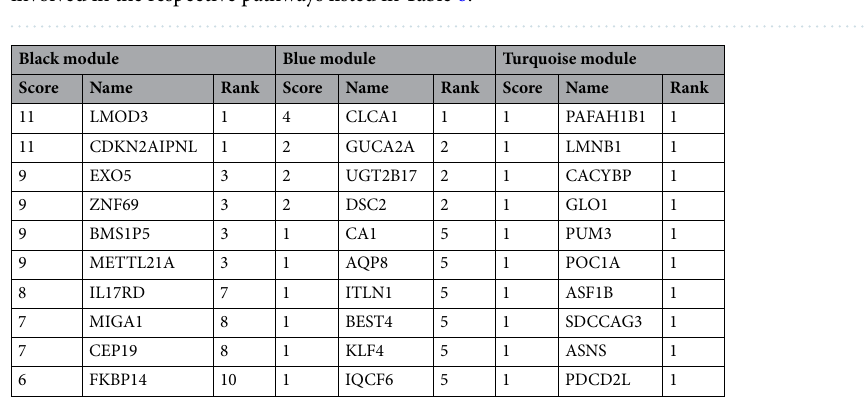
Figure 6. Turquoise module network. The top 10 genes in this module all have the same score and are equally involved in the respective pathways listed in Table 6.